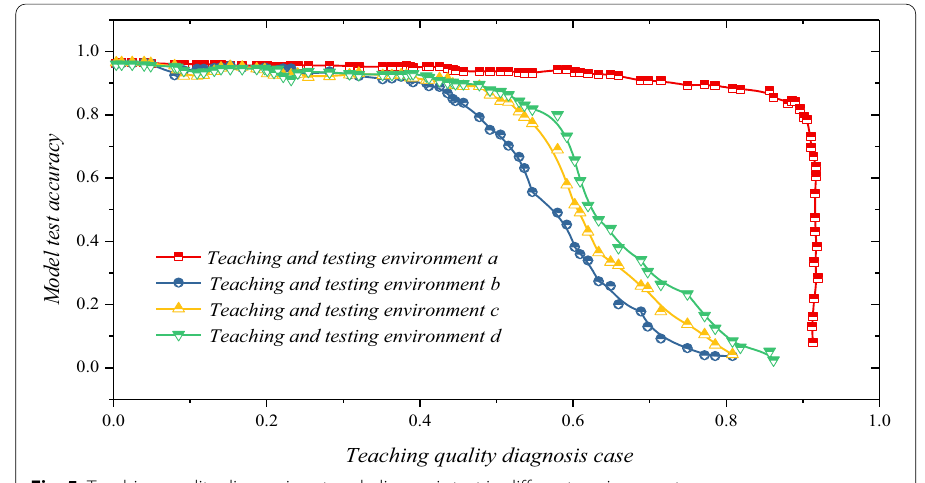
Fig. 5 Teaching quality diagnosis network diagnosis test in different environments